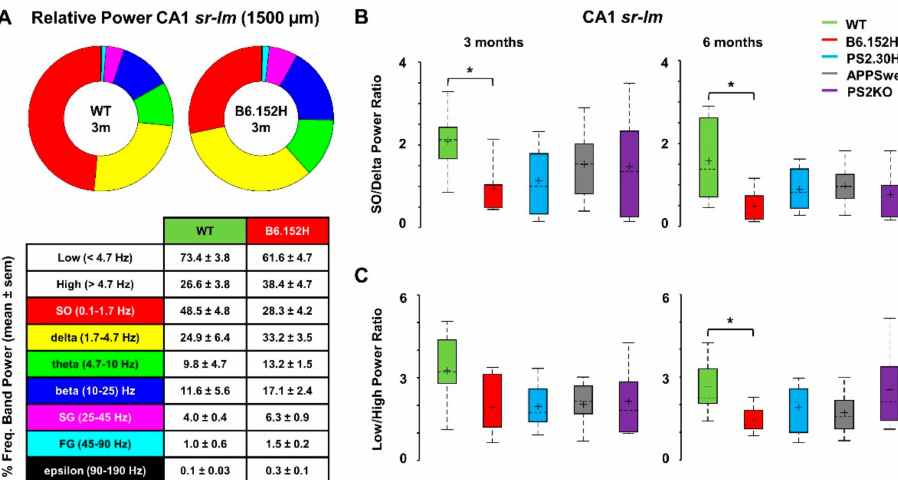
Figure 3. Hippocampal power imbalances characterize B6.152H mice. Ring charts of the relative power distribution in the di ff erent frequency bands in CA1 ( sr-lm ) of three-month-old WT and B6.152H mice ( A ), top panel); relative power at each frequency band expressed as percentage of total power (mean ± SEM) ( A ), bottom panel). Boxplots of the power ratios between SO (0.1–1.7 Hz) and delta (1.7–4.7 Hz) bands ( B ), and between Low (0.1–4.7 Hz) and High (4.7–190 Hz) frequency bands ( C ), at three and six months of age, * p <